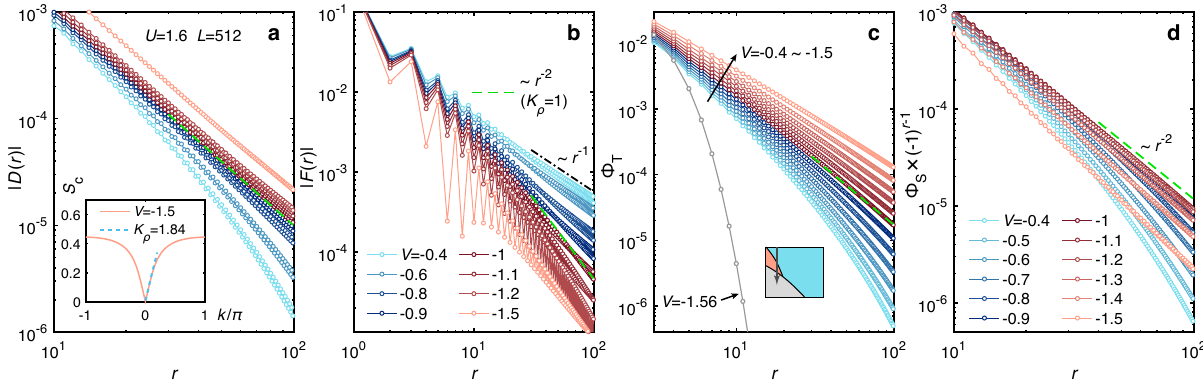
Fig. 3 Correlation functions of the half- fi lled EHM at U = 1.6. Here we show a density-density, b spin-spin, c the spin-triplet pairing, and d singlet pairing correlations, with various attractive interactions − 1.5 ≤ V ≤ − 0.4. The color codes in the four panels are the same (following the representative color of each phase in Fig. 1b, as indicated by the legends in b , d ). The dashed green line represents ∼ r − 2 scaling that corresponds to K ρ = 1, separating the exponential and power-law behaviors of various correlations in a , c , d . The dotted dash line ∼ r − 1 with exponent α = 1 in b represents long-distance scaling of the spin correlations in the SDW phase. The inset in a shows the charge structure factor at V = − 1.5, whose second-order polynomial fi tting (dashed cyan line) results in a Luttinger parameter of K ρ = 1.84.